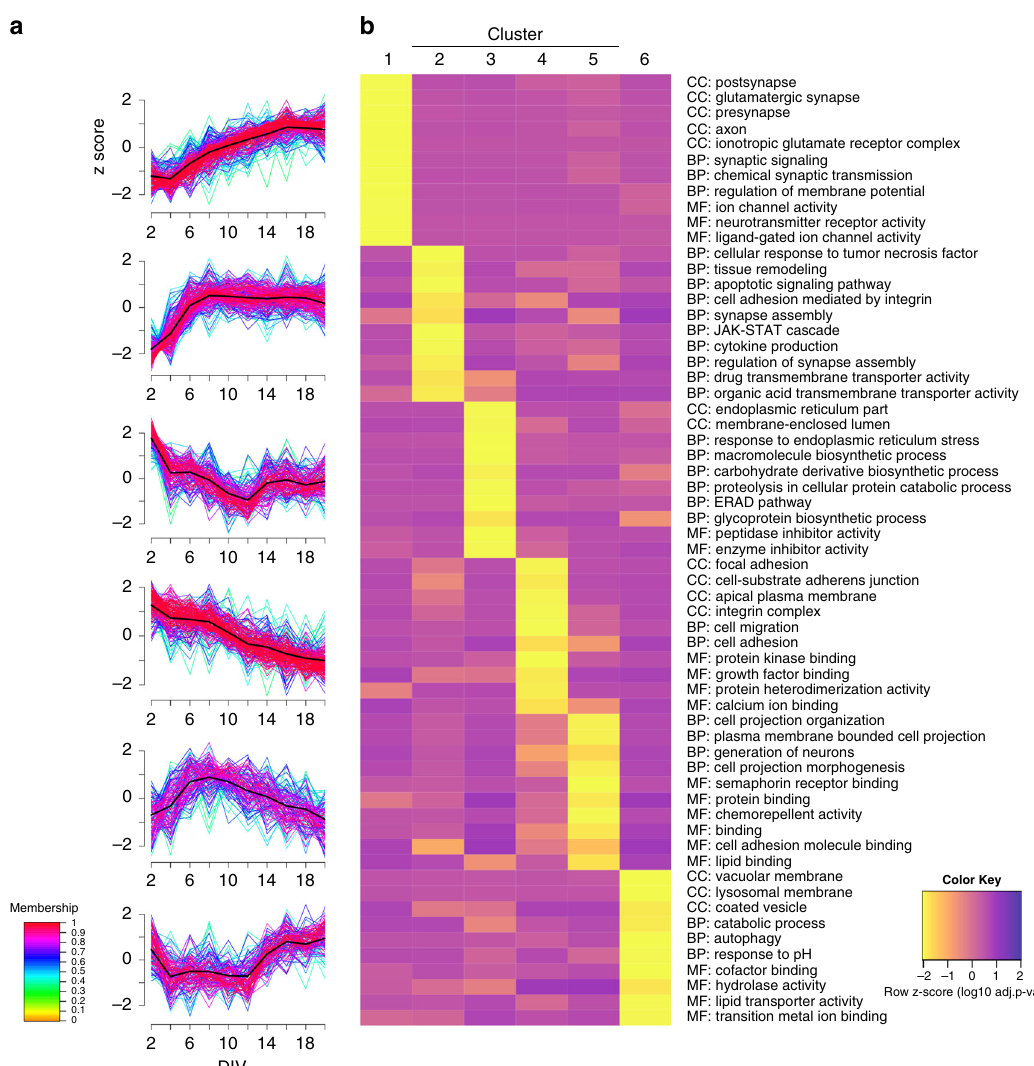
Fig. 2 Surface abundance pro fi les reveal developmental stage speci fi c patterns. a Unsupervised c-means fuzzy clustering of surface abundance pro fi les reveals six distinct clusters. Colors indicate cluster membership. b Representative GO annotations for each cluster demonstrating that MF molecular functions, CC cellular components, and BP biological processes are enriched in at least one cluster ( p < 0.05, Fisher ’ s exact test). Source data are provided as a Source Data fi